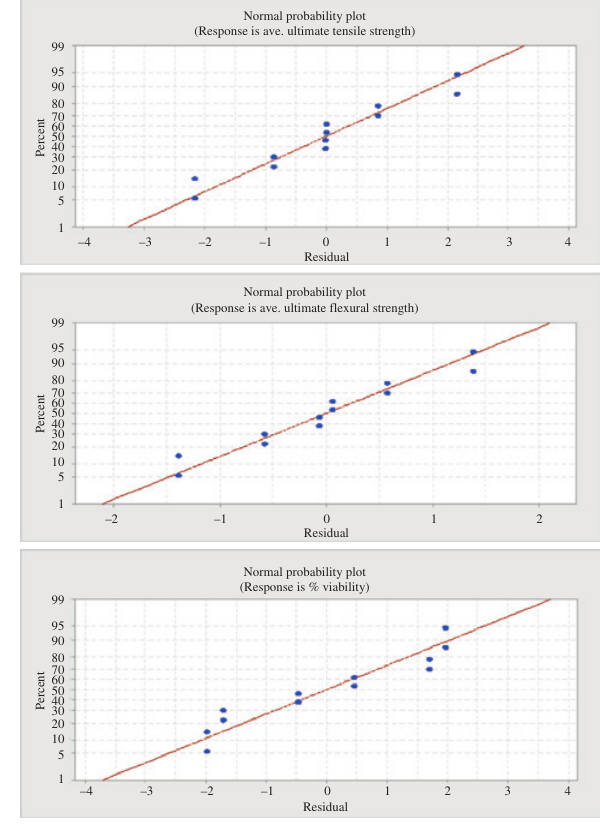
Figure 5: Normal probability plot of